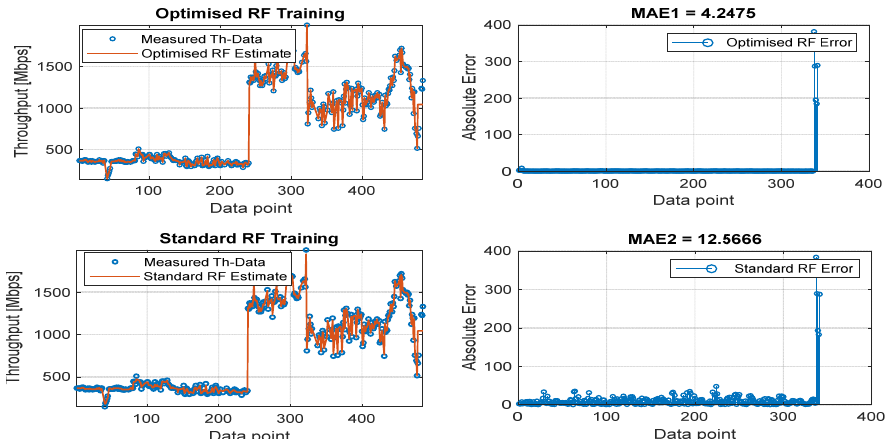
Figure 12. Predicted throughput quality performance of the proposed RF-LS-BPT model and standard RF model at 160 m distance.